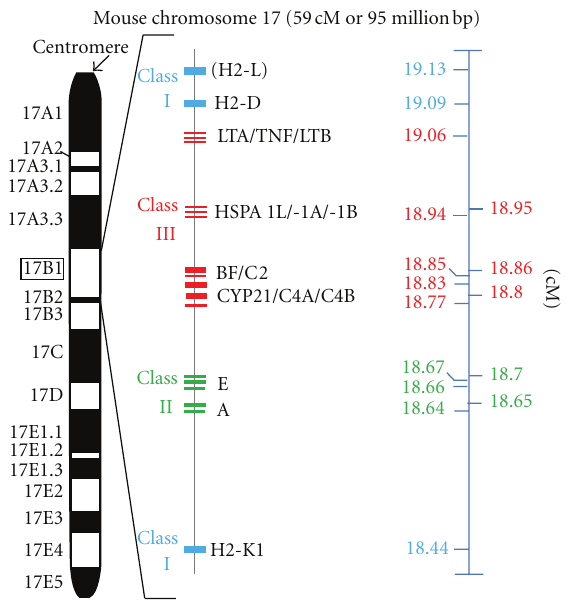
Figure 2: H-2 gene cluster and lupus susceptibility genes on mouse chromosome 17. Ideogram of chromosome 17 (middle) and schematic diagram of the MHC-complex-associated genes at 17 B1 (boxed left). The coding region of the genes is shown as small blue (class I), green (class II), and red (class II) rectangles, respectively. There are 11 mouse MHC subclasses, ranging from 18.4 to 20.3 centimorgan (cM). However, the organization of the “classical” MHC classes is similar in human and mouse. The MHC class I consists of two major loci, K and D, which are (unlike the human MHC class I counterpart) separated by the class II and class III genes. The class II gene complex is known as the I region (from “immune response”) and the class II genes are also termed “Ir genes”. Class III lupus susceptibility genes are tumor necrosis factor alpha (TNF), cytochrome P450 21-hydroxylase a1 (CYP21) as well as the complement factors C2, C4A, and C4B, respectively. Note, that cM is a nonlinear genetic distance unit of recombinant frequency, which is influenced by several